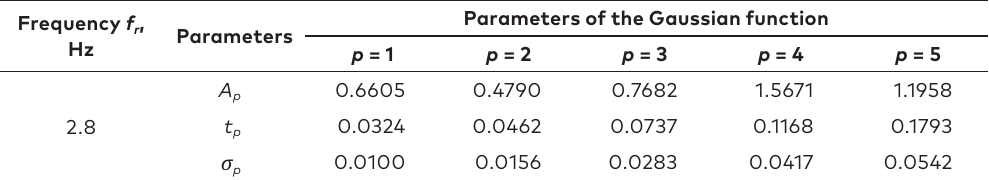
Table 6. Parameters of the template for running frequency of 2.8 Hz